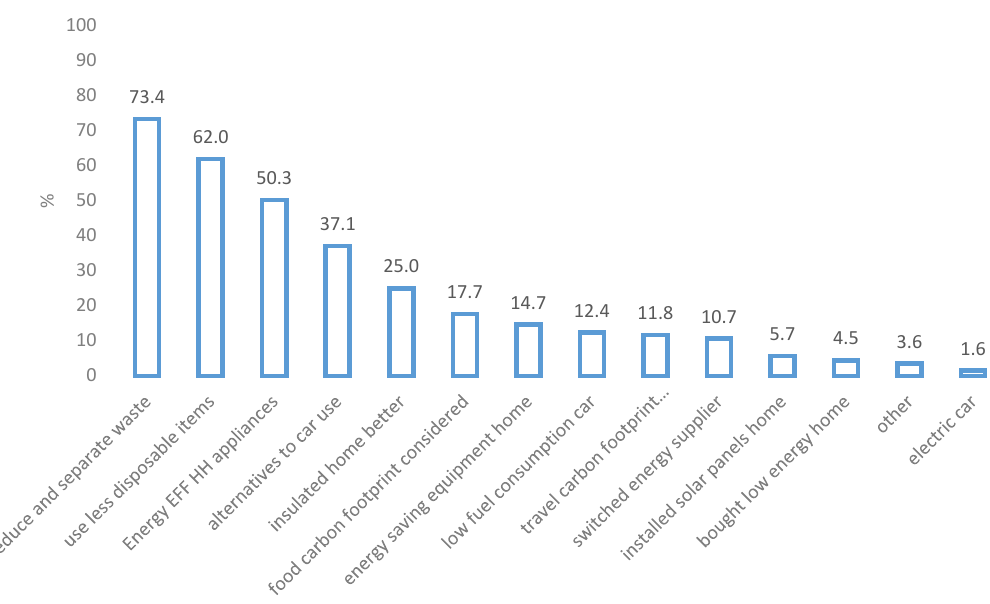
Figure 5. Types of individual action taken to fight climate change. Source: Author’s contribution